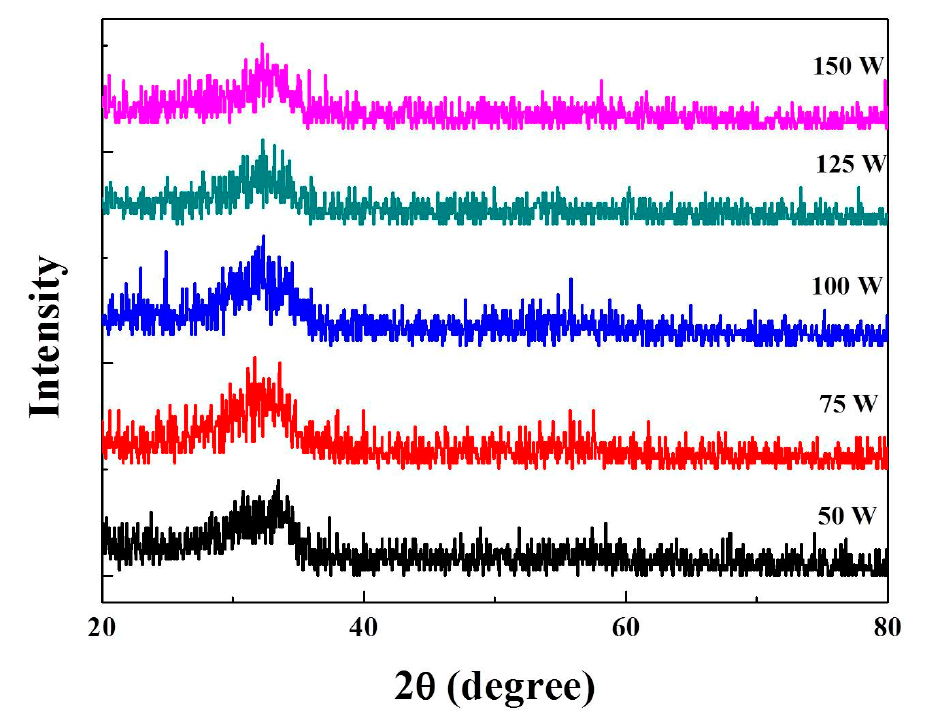
Figure 3. XRD of the IZTO films deposited with various sputtering powers.